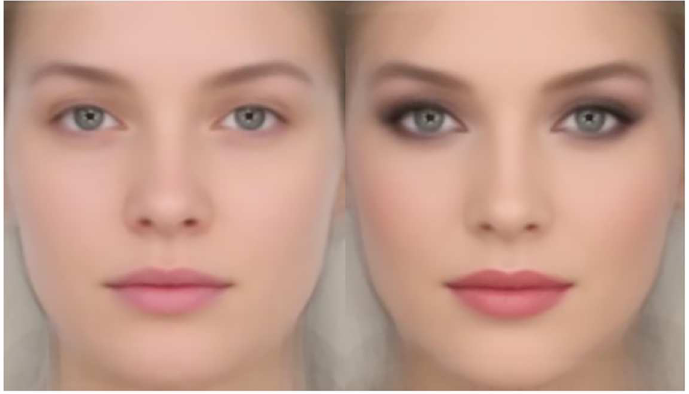
Fig 1. The average model without (left) and with cosmetics (right). These averages are cropped mid- foreheadbecause several of the YouTubevideos presented individuals in this way, resulting in insufficient information above this point for generating